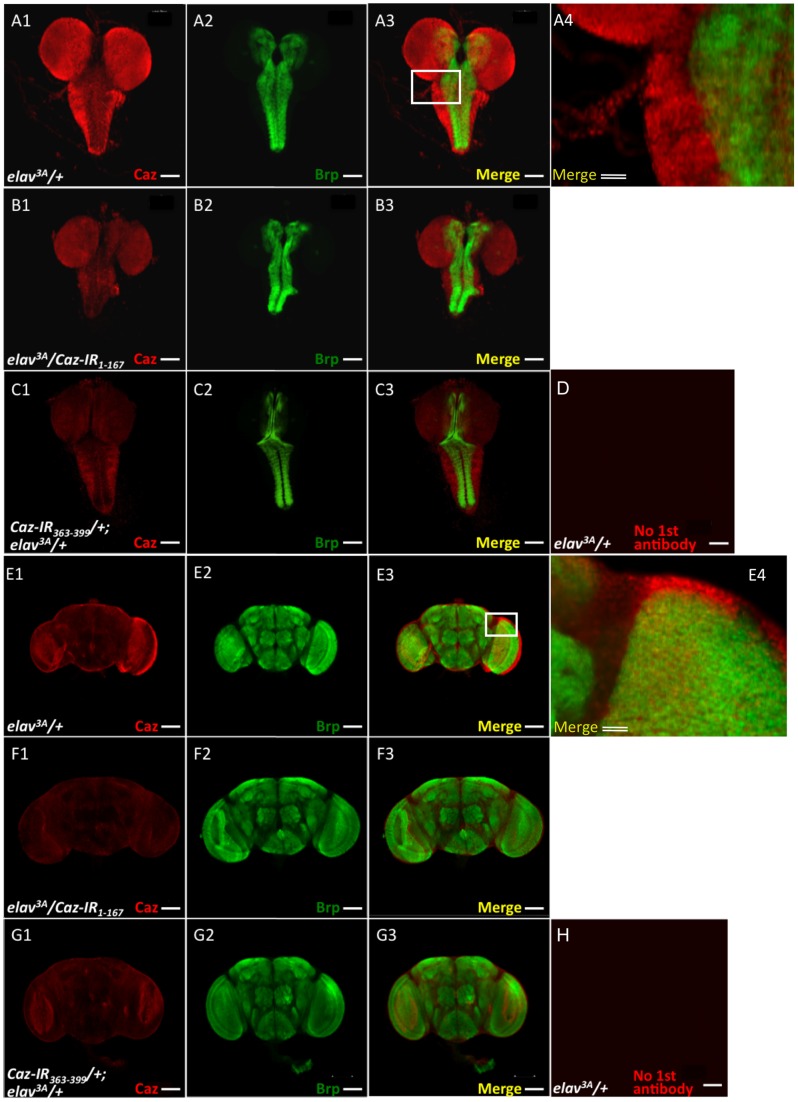
Immunohistochemical localization of Caz in larval and adult brains.Brain-ventral ganglia complexes from third instar larvae (A–D) and whole mount adult heads (E–H) were stained with the polyclonal anti-Caz antibody (A-1, B-1, C-1, E-1, F-1, G-1) or with an antibody against the neuropil marker Bruchpilot (Brp) (A-2, B-2, C-2, E-2, F-2, G-2). Merged confocal images of the two stains are shown at right (A-3, B-3, C-3, E-3, F-3 and G-3, respectively). Higher-magnification images of the boxed area in A-3 and E-3 are shown in A-4 and E-4, respectively. (D, H) Images of staining in the absence of first antibody. A-1 to A-4, E-1 to E-4, controls carrying elav3A/+; B-1 to B-3, F-1 to F-3, Caz-knockdown flies carrying elav3A/Caz-IR1-167; C-1 to C-3, G-1 to G-3, Caz-knockdown flies carrying Caz-IR363-399/+;elav3A/+. Caz antibody immunoreactivity decreased in CNS tissues from both the third instar larvae and the adult flies carrying elav3A/Caz-IR1-167 (B-1, F-1) and Caz-IR363-399/+;elav3A/+ (C-1, G-1). The single bars indicate 100 μm. The double bars indicate 20 μm.